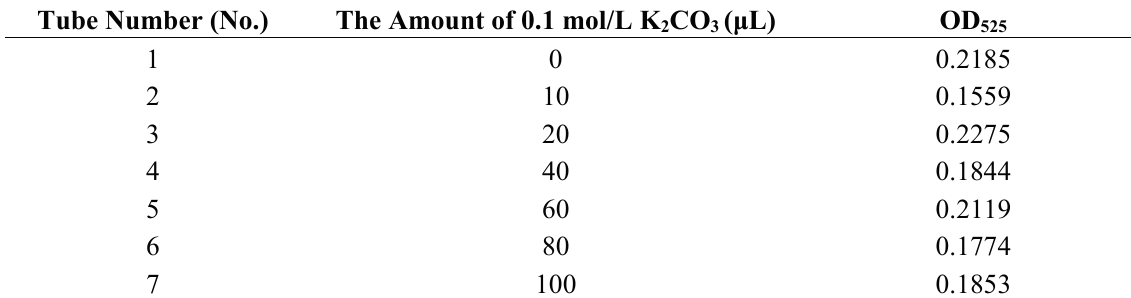
Table 1. Optimization of pH for the conjugation between colloidal gold and antibody. Tube Number (No.)